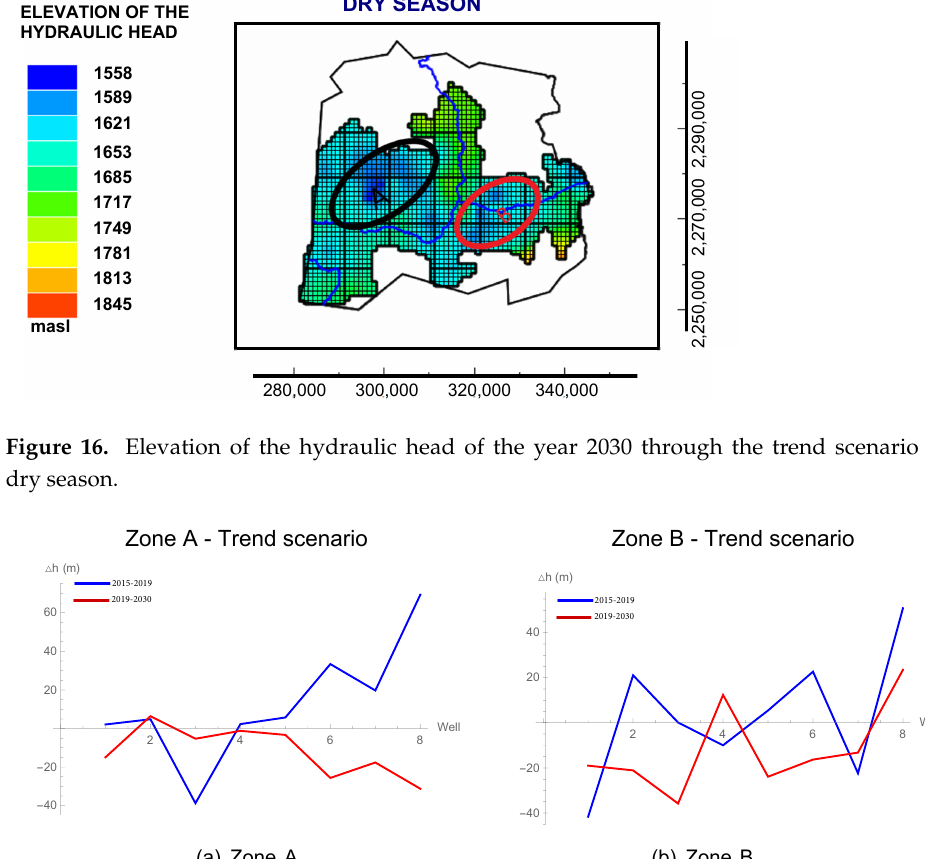
Figura 3.5: Isol´ıneas de la carga hidr´aulica del a˜no 2030 a trav´es del escenario Tendencial en la Temporada de Secas.